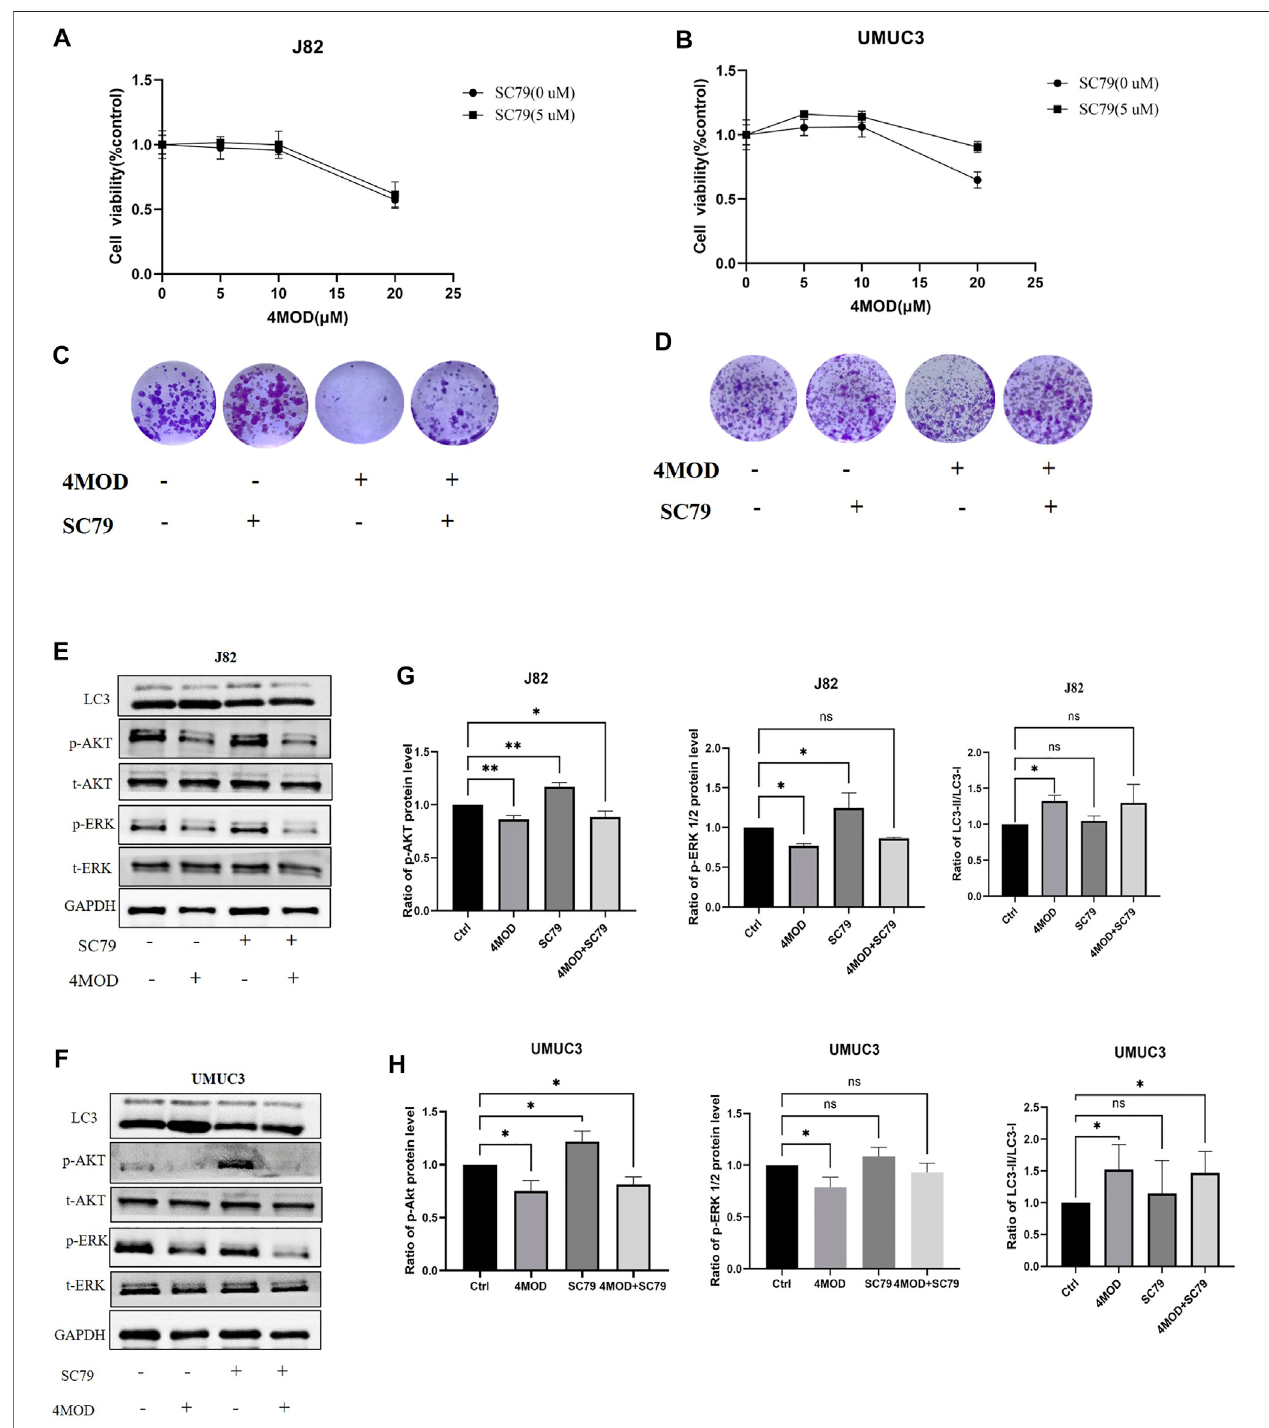
FIGURE 7 | 4MOD attenuates BC progression through inhibiting AKT/ERK signaling in vitro (A – B) Cell viability was assessed after treatment of 4MOD alone or 4MOD combinedwithAkt antagonist SC79 for72 h (C – D) UMUC3and J82cells weretreated for7 days with4MOD combined withSC79 and then stainedwith crystal violet to allow colony counting (E – F) UMUC3 and J82 cells were after treatment of 4MOD alone or 4MOD combined with SC79 for 72 h, and the protein levels of pErk, t-Erk,pAkt,t-Akt,andLC3weredetectedbyWesternblotwithGAPDHasacontrol. (G,H) TheresultsofWesternblotanalysiswerequanti fi edbyImageJsoftware. Data are presented as mean ± SD. Statistic signi fi cant differences were indicated: * p < 0.05, ** p < 0.01.